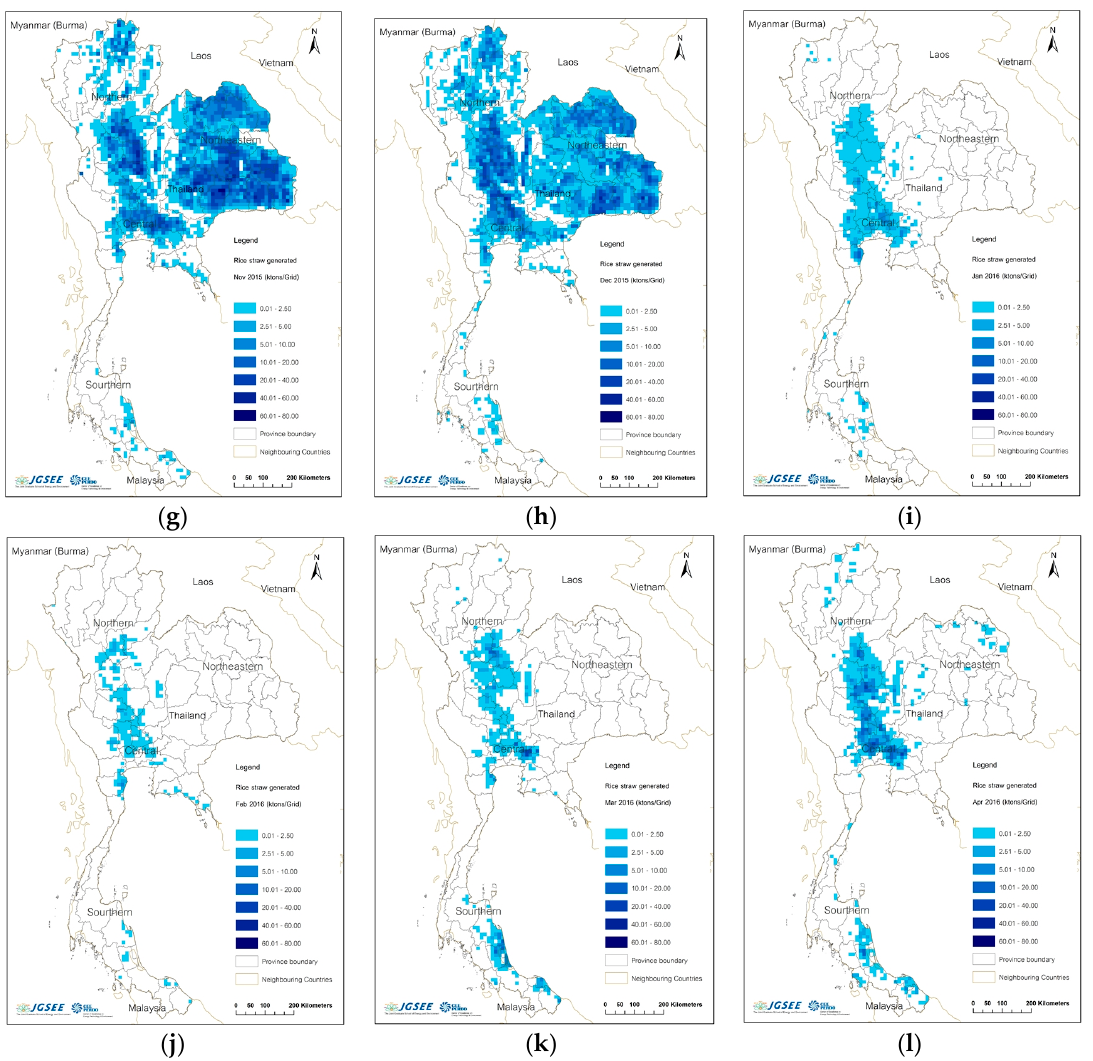
Figure 8. Spatial variation of the gross potential of rice straws for each harvesting month, consisting of ( a ) May 2015, ( b ) June 2015, ( c ) July 2015, ( d ) August 2015, ( e ) September 2015, ( f ) October 2015, ( g ) November 2015, ( h ) December 2015, ( i ) January 2016, ( j ) February 2016, ( k ) March 2016, and ( l ) April 2016.